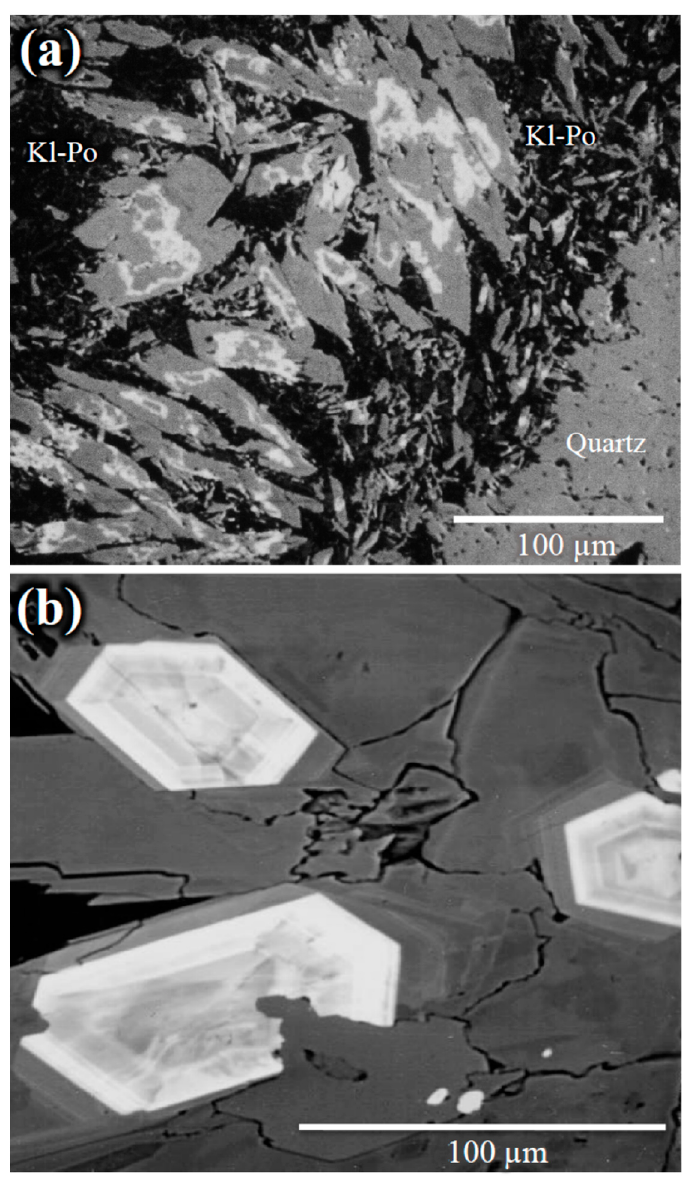
Figure 8. ( a ) Backscattered electron image of bladed-alunite crystals containing dissolved cores of woodhouseite-crandallite-svanbergite accompanying massive quartz within a fine-grained matrix of kaolinite-pyrophyllite (Rodalquilar gold-alunite ore deposit, Spain) [16]. ( b ) Backscattered electron image of alunite and APS minerals from the advanced argillic zone immediately above the FSE porphyry Cu-Au-Ag deposit, Philippines [23]. These photographs are modified and referred from [16] and [23],